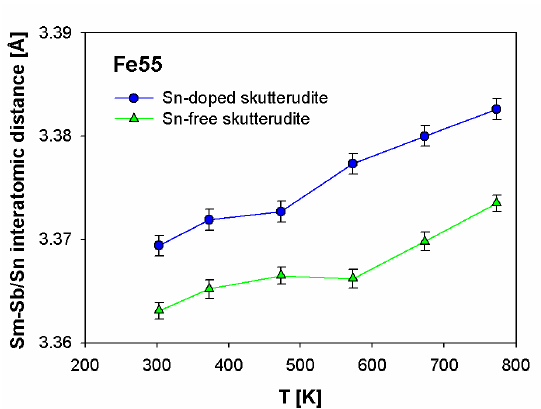
Figure 9. Trend of the Sm–Sb interatomic distances as a function of the temperature for the sample Fe55 of the Sn-containing and the Sn-free skutterudite systems; the data of the latter are taken from ref. [61]. The dashed lines are regression lines.